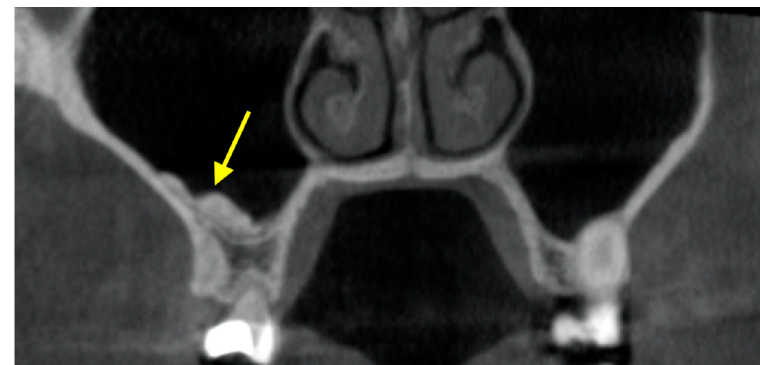
Figure 6. Antrolith found on the sinus floor of the right maxillary sinus.